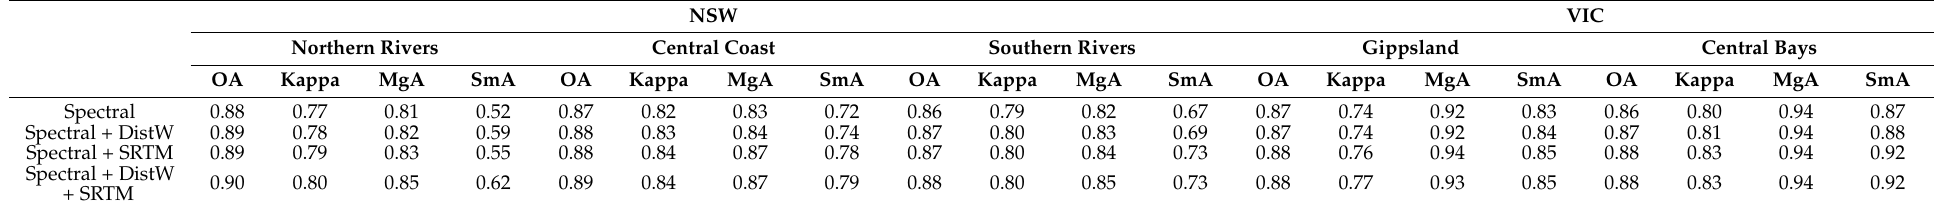
Table 4. Overall Accuracy (OA), Kappa statistics, and class specific balanced accuracies for Mangroves (MgA) and Saltmarsh (SmA) across all regions of interest for the 2006/Landsat 5 model after applying post-classification filters.